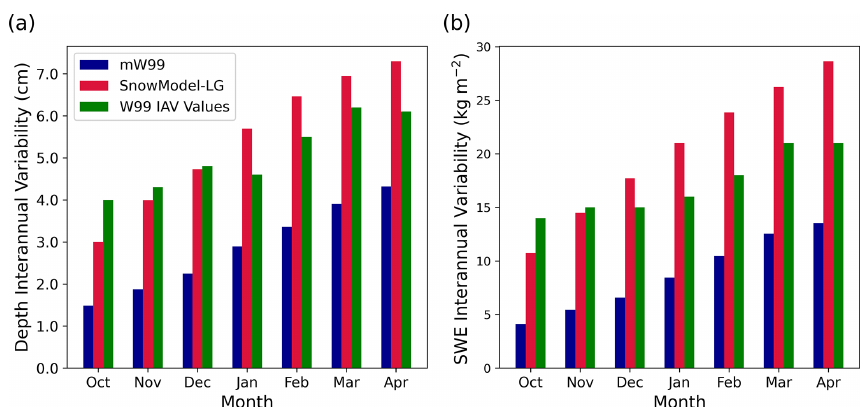
Figure 3. Interannual variability (2002–2018) in snow depth from mW99 and SnowModel-LG compared to the values given in Table 1 of Warren et al. (1999).